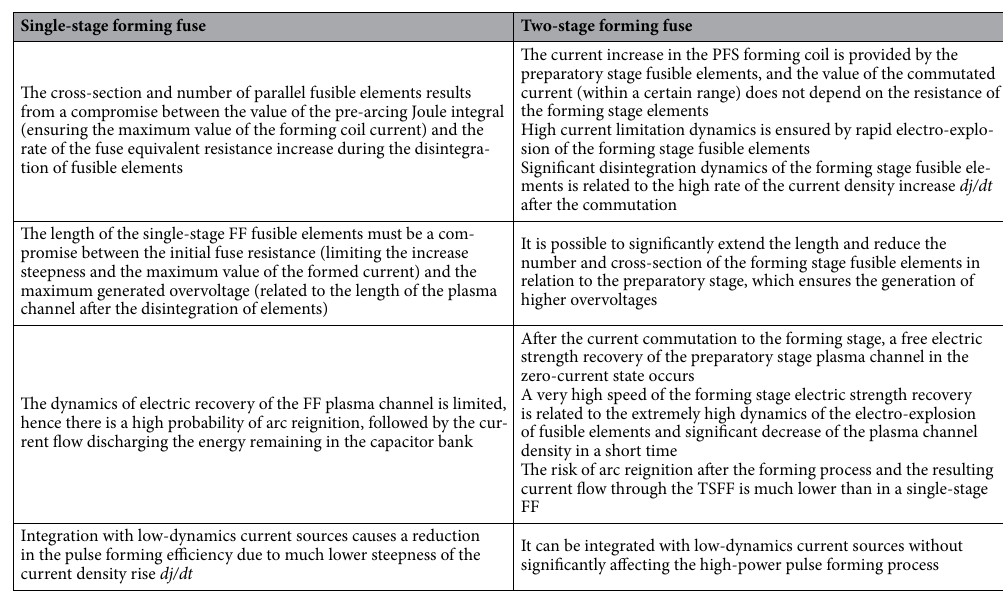
Table 1. Comparing features of two-stage and single-stage forming